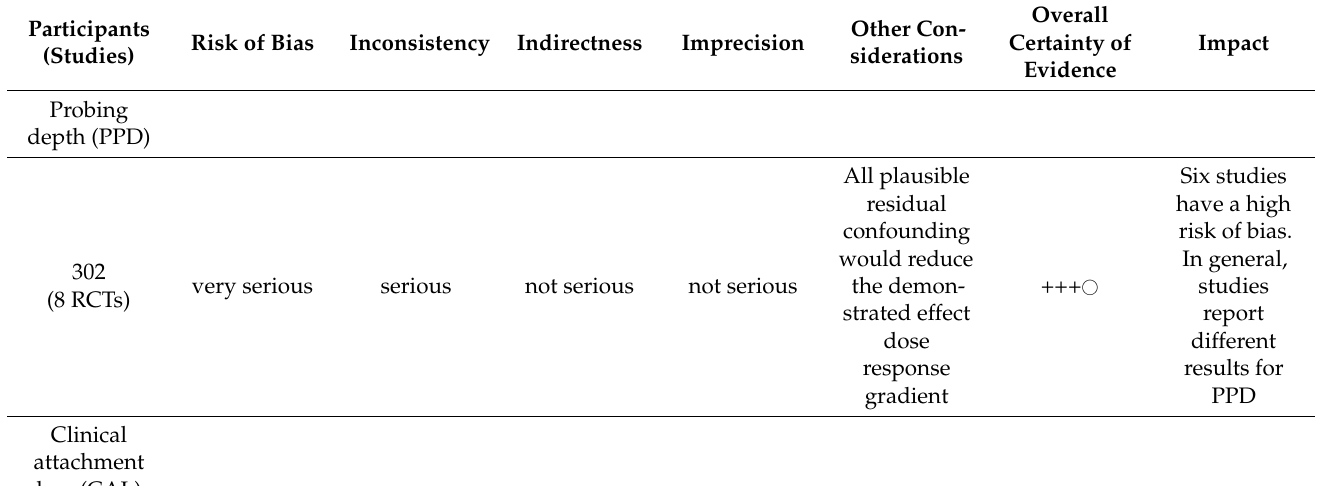
Table 4. Summary of findings based on quality and body of evidence.